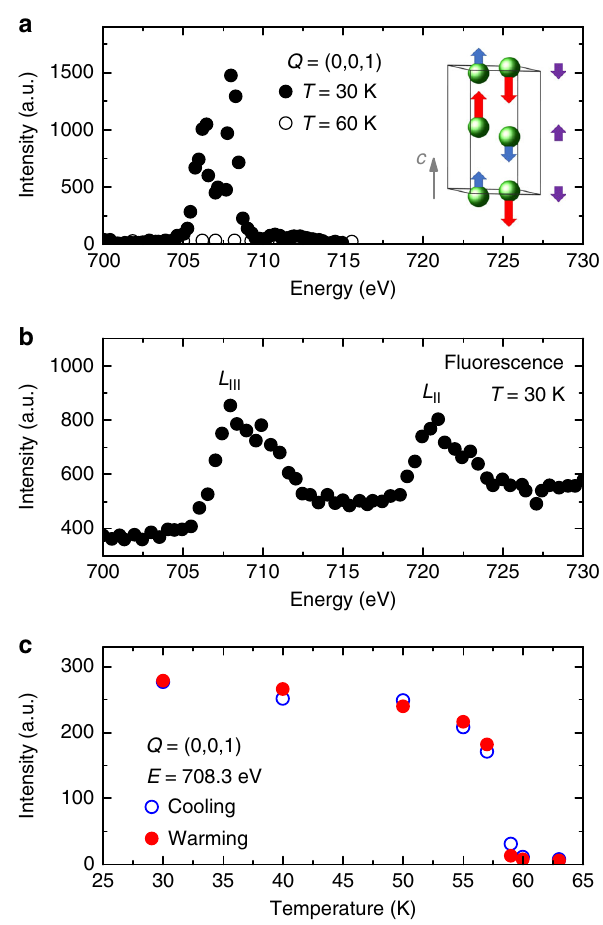
Fig. 2 Resonant magnetic X-ray diffraction in Fe 2 Mo 3 O 8 . a Right. The magnetic order in Fe 2 Mo 3 O 8 . Blue and red arrows represent Fe 2 + magnetic moments at two different crystallographic sites, the difference between the moment magnitudes is exaggerated. Purple arrows represent the net magnetic moments of the Fe planes stacked along the c axis. Left. Magnetic resonance at the (0,0,1) magnetic Bragg peak. b X-ray fl uorescence through the L II and L III absorption edges. c Temperature dependence of the magnetic (0,0,1) peak intensity, representative of the magnetic